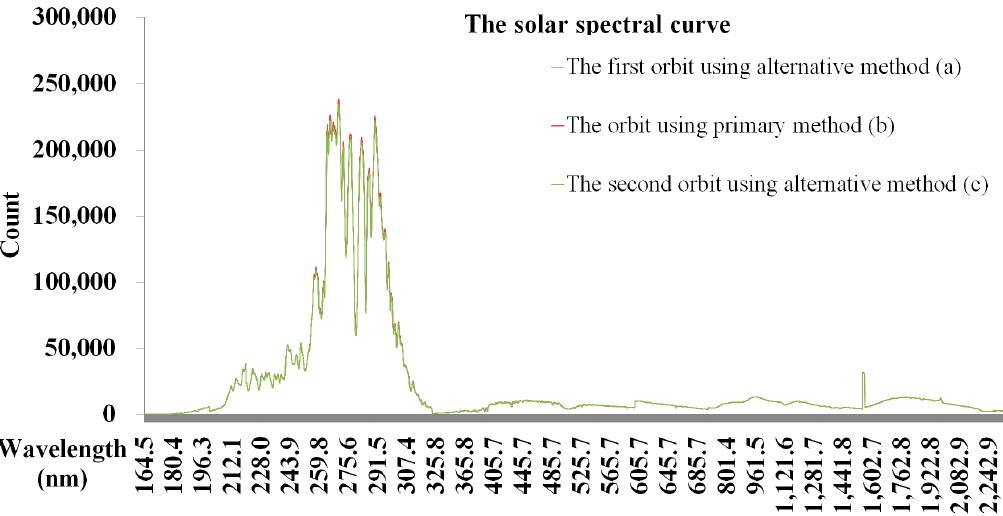
Figure 9. The solar spectral curve.